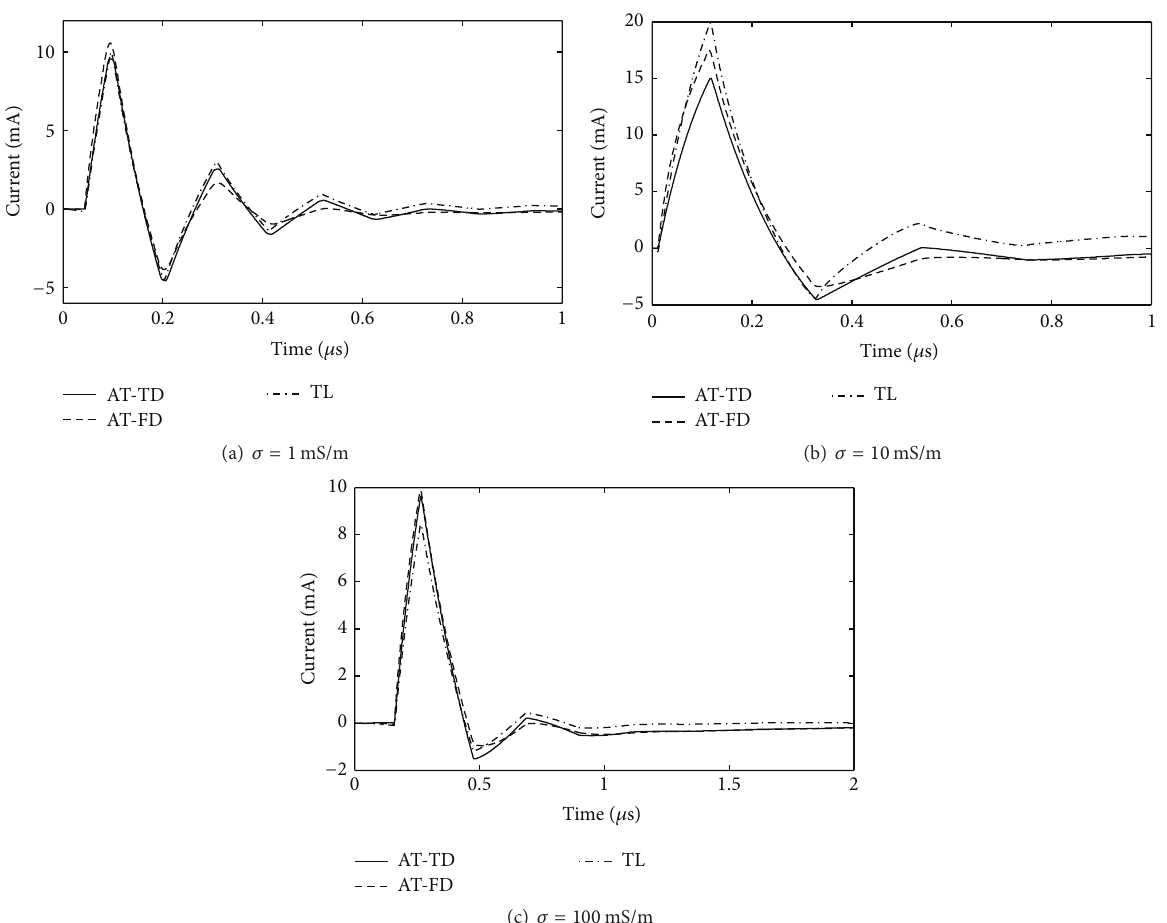
Figure 3: Transient current at the centre of the straight wire: 𝐿 = 10 m and 𝑑 = 4 m.